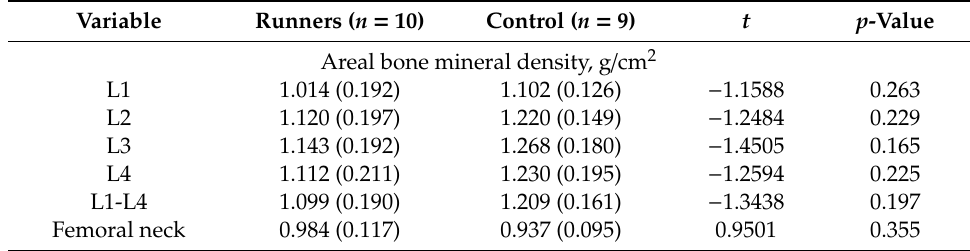
Table 4. Areal bone mineral density and body composition (lean and fat mass) in runners ( n = 10) and controls ( n =